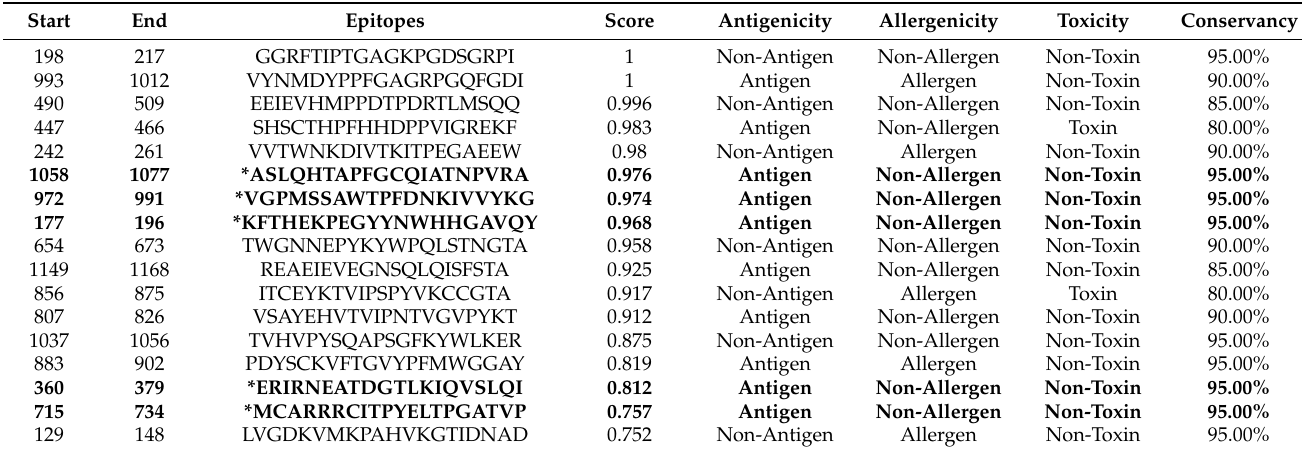
* The rows in bold represent the final selected peptides.